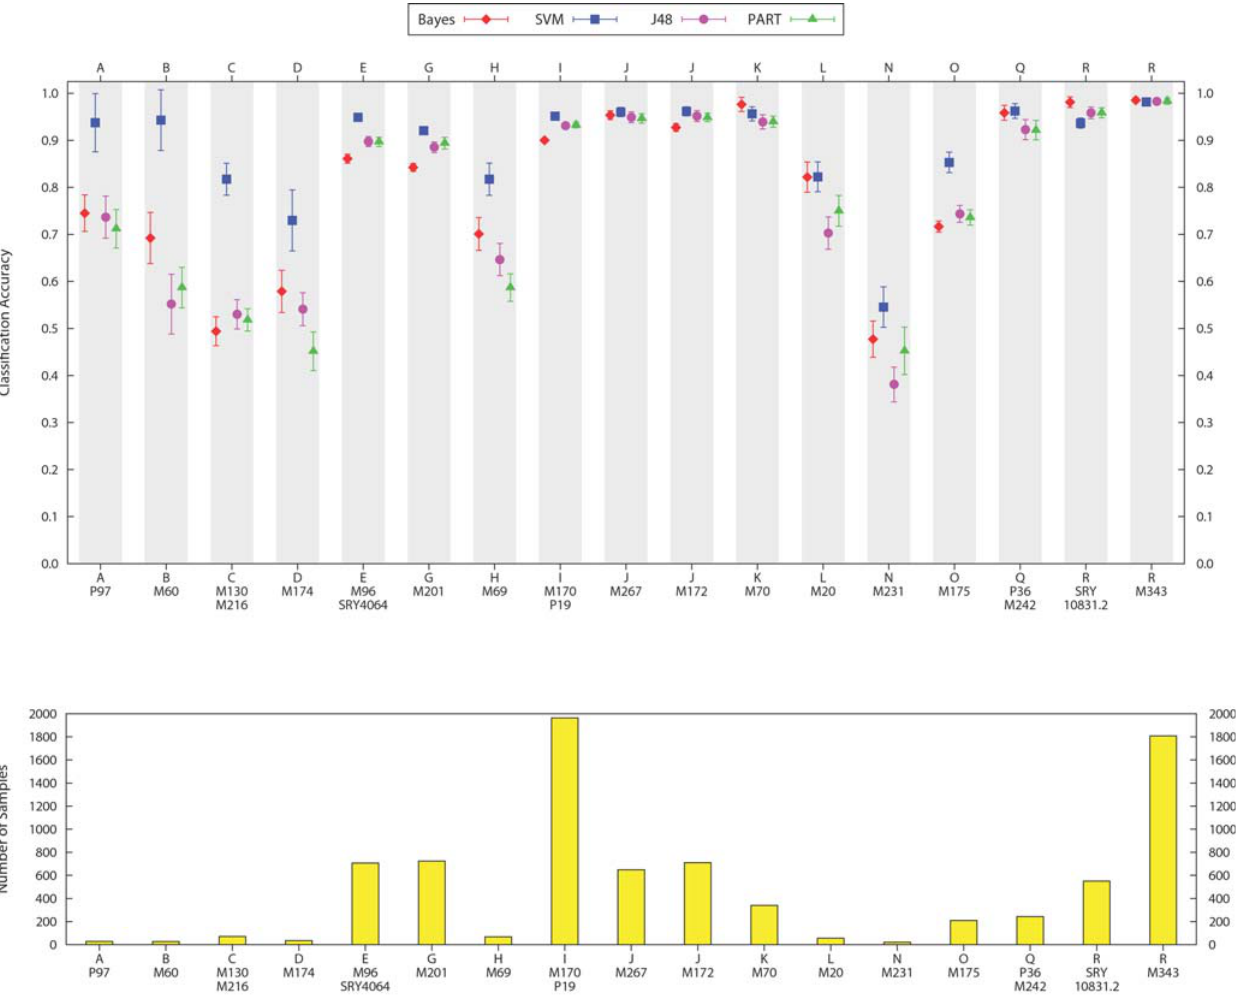
Figure 2. Average accuracy of each classifier per haplogroup for cross-validation on the ground-truth training set. Standard error bars are shown for each point. The lower panel shows the frequency of the 8,414 samples among haplogroups. Support vector machines has the best overall performance, especially in the case of haplogroups with a smaller number of samples in the training data.